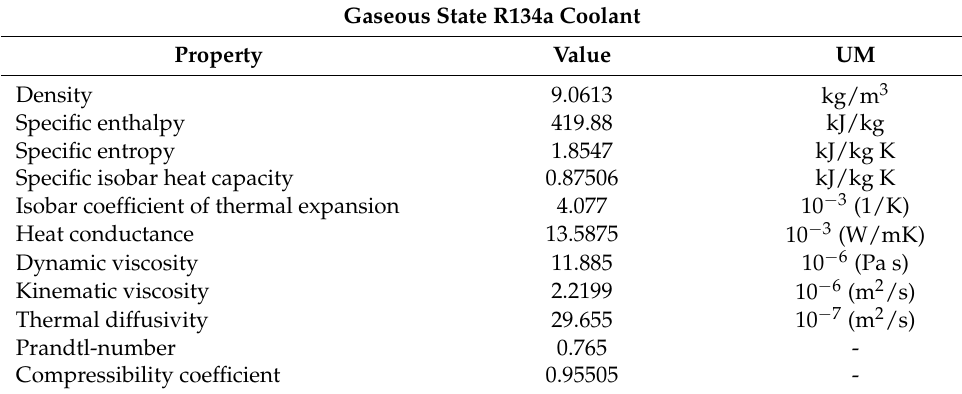
Table 4. Gaseous state R134a refrigerant